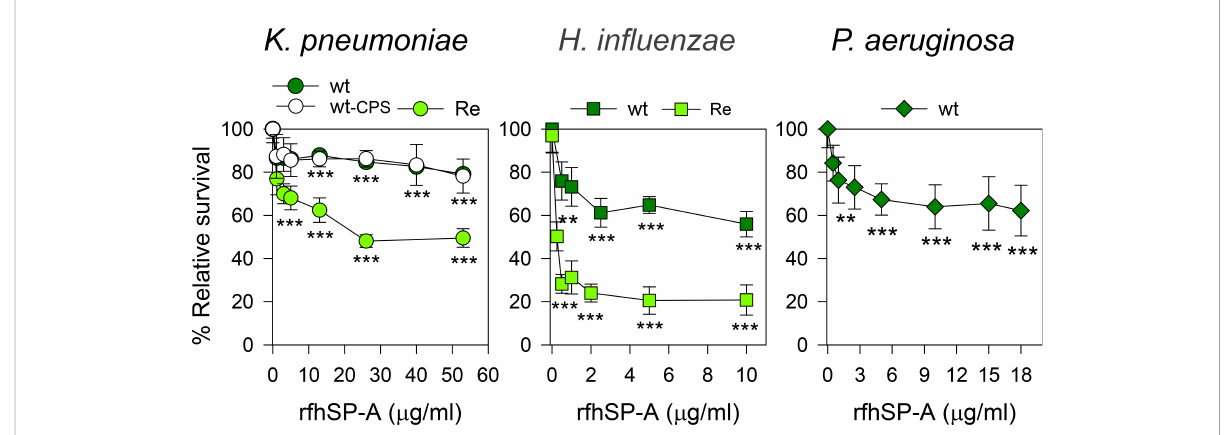
FIGURE 11 rfhSP-A kills Gram-negative bacteria. 10 5 CFUs/ml of different strains of Kp, NTHi, or PAO1 were incubated with increasing concentrations of rfhSP-A in 10 mM phosphate buffer (pH 7.4) containing 1% TSB and 100 mM NaCl for 1 h at 37°C. Bacteria were then plated on LB agar (Kp and PAO1) or sBHI agar (NTHi) for CFU counting. Results are shown as a percentage of relative survival compared to untreated bacteria. Importantly, SP-A had no effect on the survival of these pathogens at molar concentrations equivalent to or greater than the molar concentrations of rfhSP- A. Data are means ± SD of three independent experiments, with three biological replicates. Experiments were performed with both polymyxin- agarose treated and untreated rfhSP-A, to remove LPS contamination, with identical results. Results were statistically analyzed by one-way ANOVA followed by the Bonferroni multiple-comparison test. ** p < 0.01, and *** p < 0.001 when bacterial strains treated with rfhSP-A were compared with those not treated with